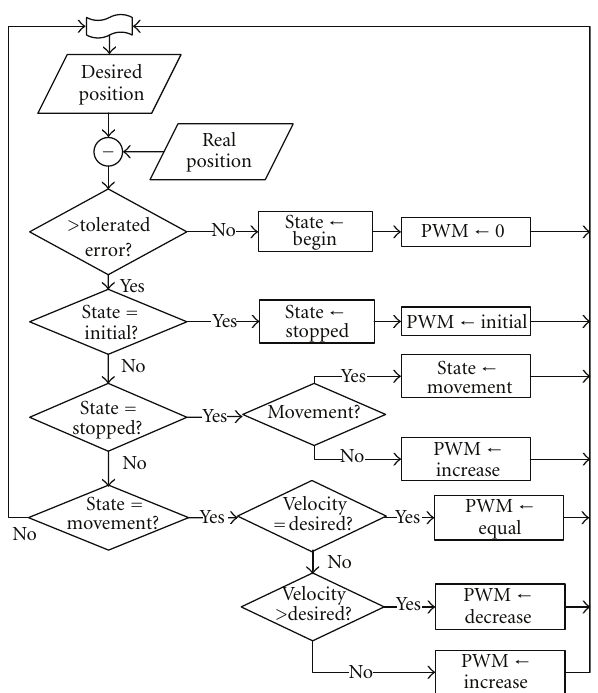
Figure 7: Fluxogram of the NCS control strategy developed.